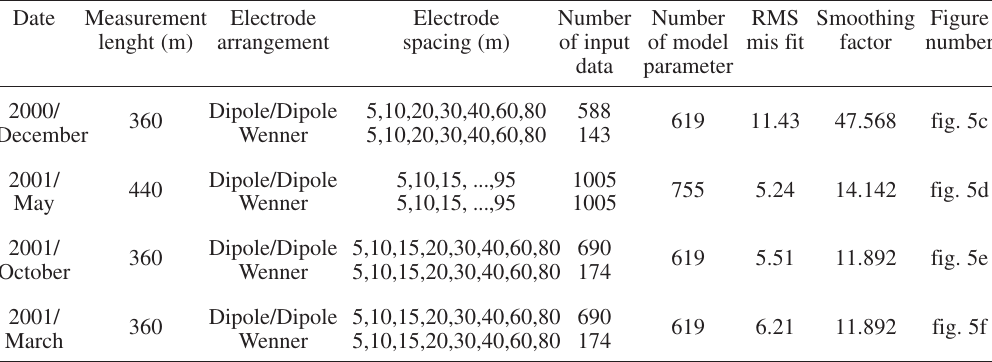
Table II. The specifications of the electrical sounding and modeling. Measurement